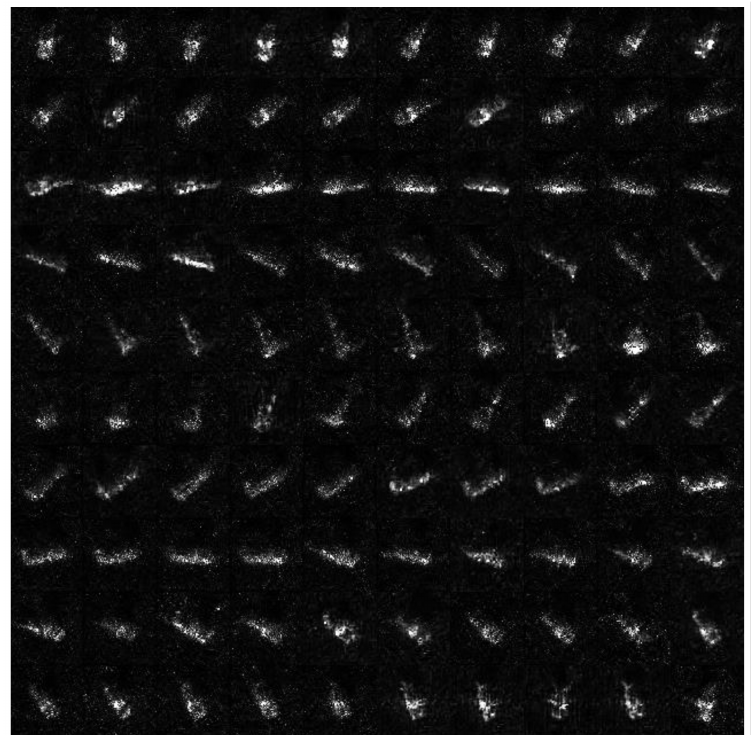
Figure 12. Examples of generated SAR target images at various pose angles with N TR = 100; “ZIL131”- class SAR images of D PeaceTR to D 17 . 17, GAN